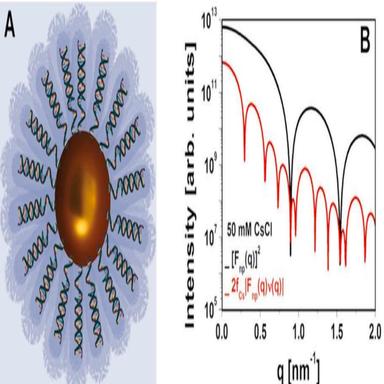
A) Schematic of a gold nanoparticle coated with oligonucleotides. B) Model SAXS intensity calculations for the case of SNA-AuNPs in 50 mM CsCl showing contributions from the dominant cation-independent term (top black line) and weaker cation-distribution-dependent term (red line). Reprinted with permission from. Copyright 2013 American Chemical Society. (For interpretation of the references to colour in this figure legend, the reader is referred to the web version of this article.)